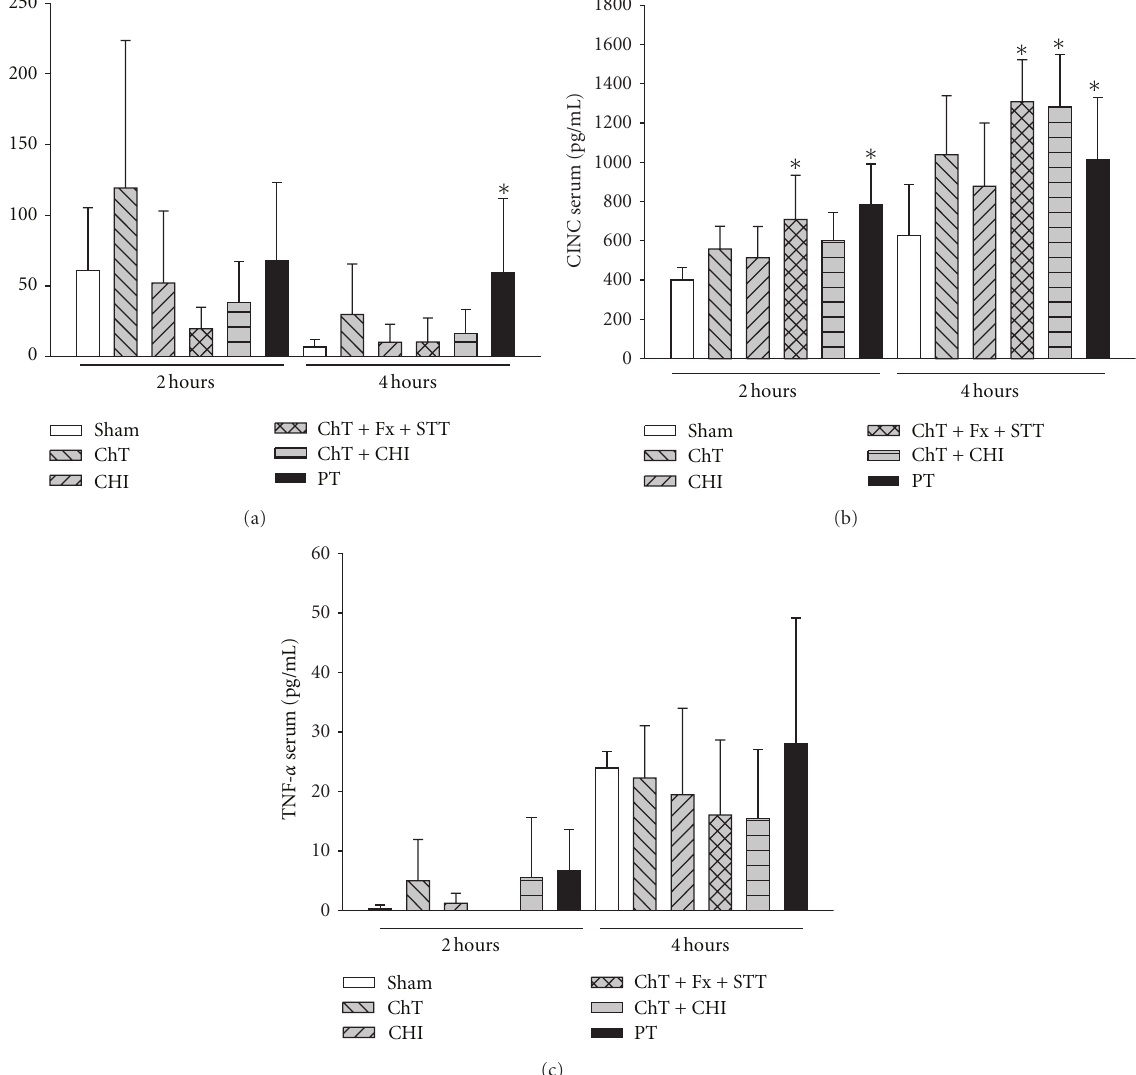
Figure 1: Systemic inflammatory response following trauma , (a) shows the systemic IL-6 (pg/mL) serum levels in Sham versus PT animals 2 and 4 hrs after trauma, (b) the CINC (pg/mL) serum concentrations in Sham versus PT animals 2 and 4hrs after trauma and (c) the TNF- α (pg/mL) serum levels in Sham versus PT animals 2 and 4hrs after trauma. All data are presented as mean ± SD. ∗ P < 0 . 05. n = 6–10